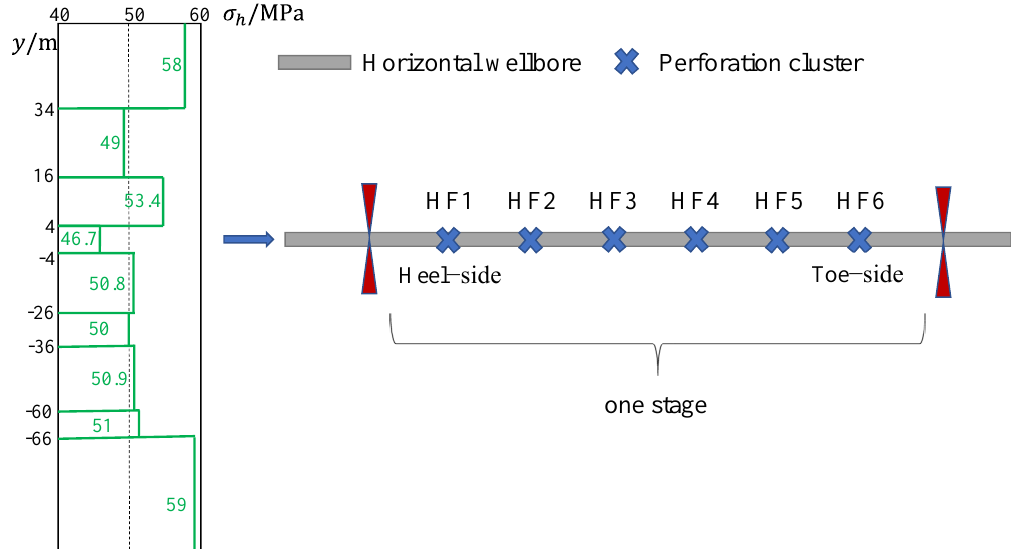
Figure 3. Schematic diagram of positions of perforation clusters in the horizontal well.